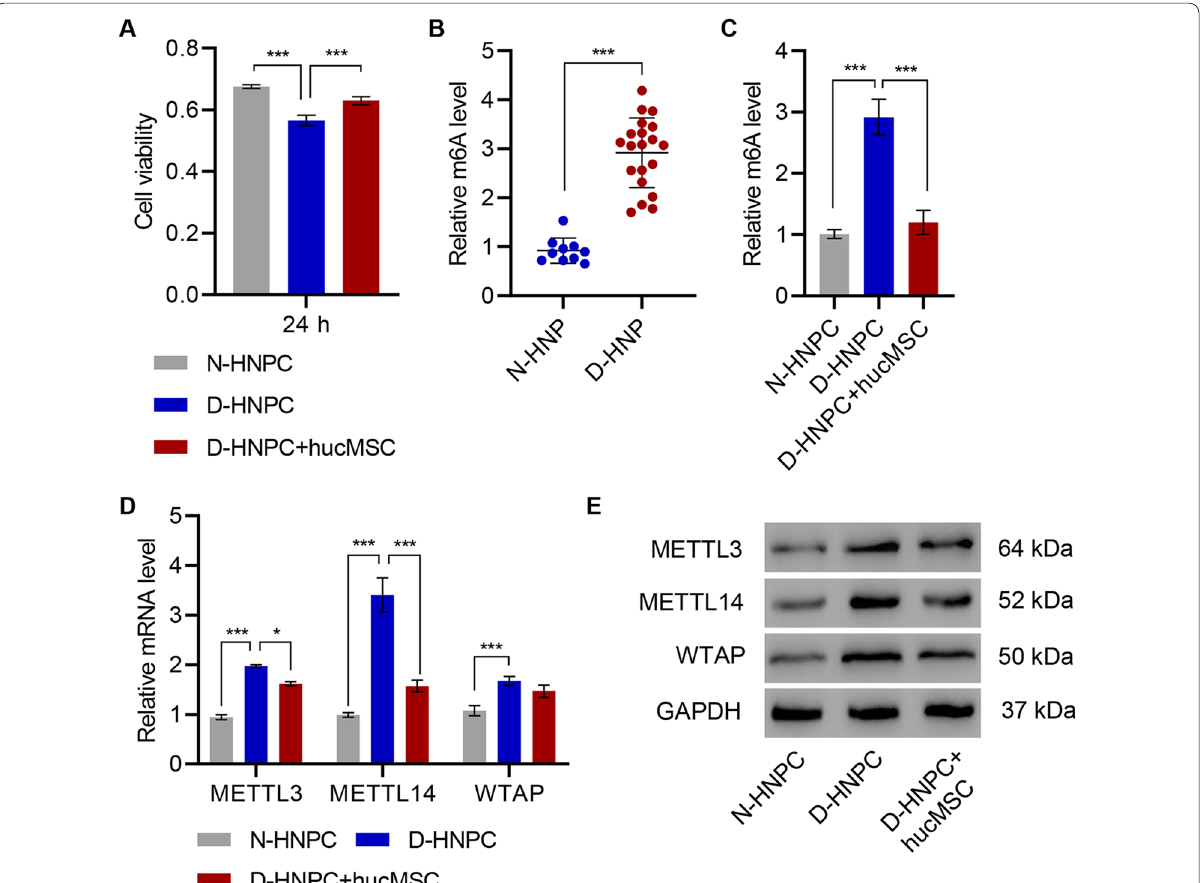
Fig. 1 HucMSC promotes cell viability and inhibits the expression of methyltransferases in HNPC. A Cell viability and ( D , E ) expression of METTL3, METTL14, and WTAP in HNPC isolated from patients with intervertebral disc degeneration (D-HNPC) or normal controls (N-HNPC) with or without hucMSC coculture. B , C m 6 A levels in HNP tissues or HNPC isolated from patients with intervertebral disc degeneration (D-HNP; D-HNPC) or normal controls (N-HNP; D-HNPC). * P < 0.05, *** P <